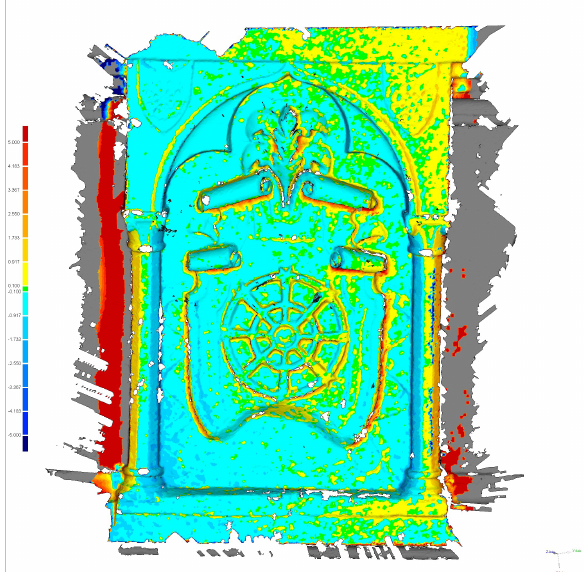
Figure 7. Results of 3d compare of bas-relief